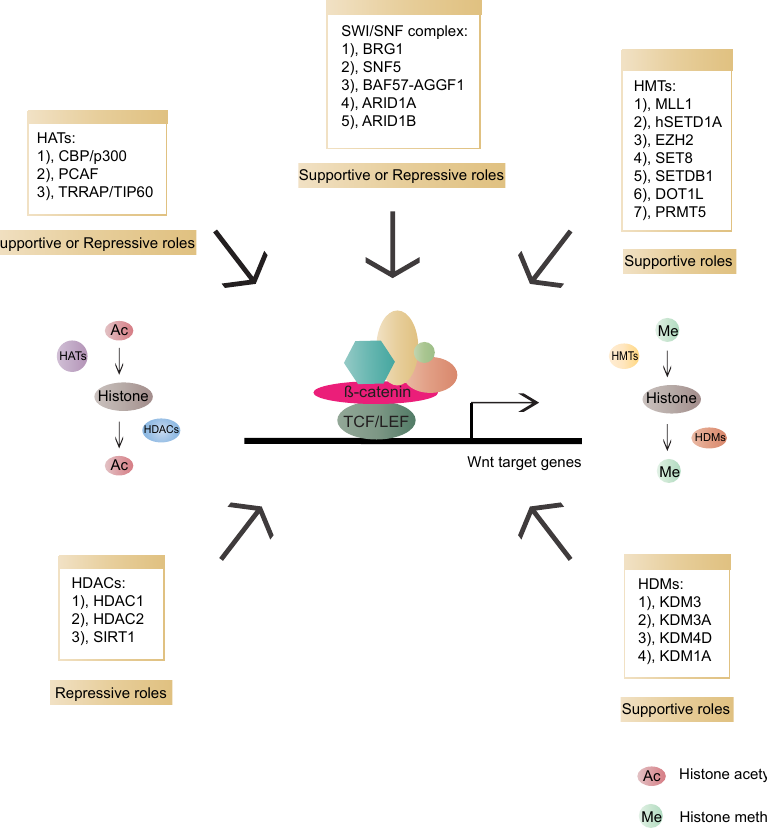
Figure 5. Overview of chromatin modifiers involved in β -catenin-dependent transcriptional regulation and their roles in the Wnt pathway. HATs (histone acetyltransferases, transferring acetyl groups to histones): CBP (CREB-binding protein) / p300, PCAF (p300 / CBP-associated factor), TRRAP (Transformation / transcription domain-associated protein) / TIP60; HDACs (Histone deacetylase, removing acetyl groups from histones): HDAC1 (Histone deacetylase 1), HDAC2 (Histone deacetylase 2), SIRT1 (NAD-dependent deacetylase sirtuin-1); HMTs (Histone methyltransferases, transferring methyl groups to histones): MLL1 (Mixed-lineage leukemia 1 or Histone-lysine